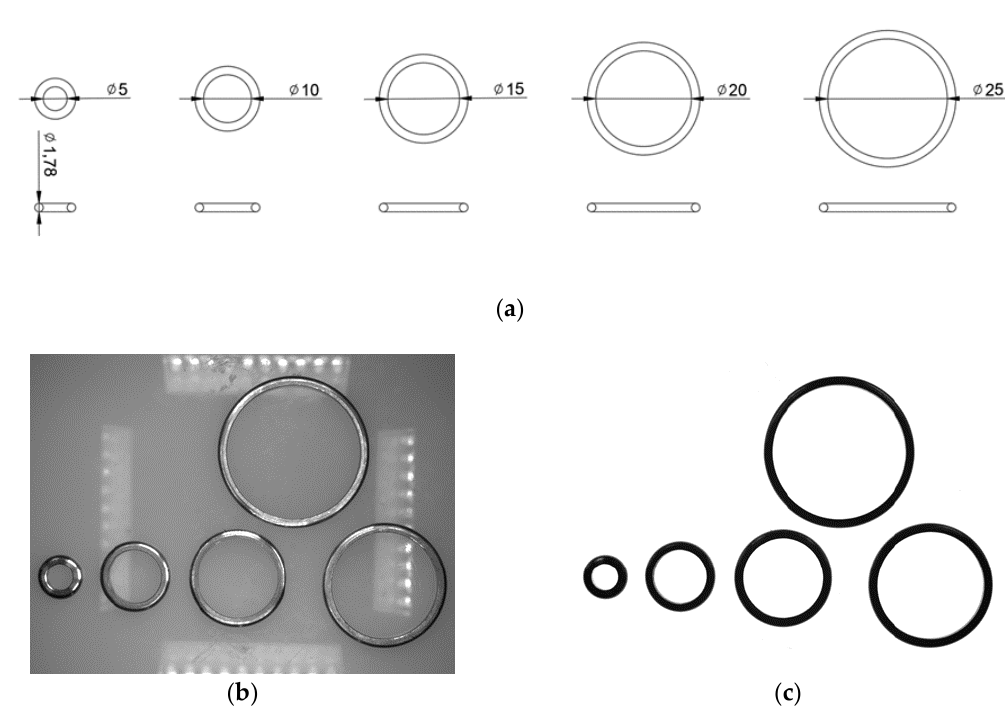
Figure 21. ( a ) CAD of the metal O-rings; ( b ) metal O-ring image (top light source); ( c ) metal O-ring image (backlight source).